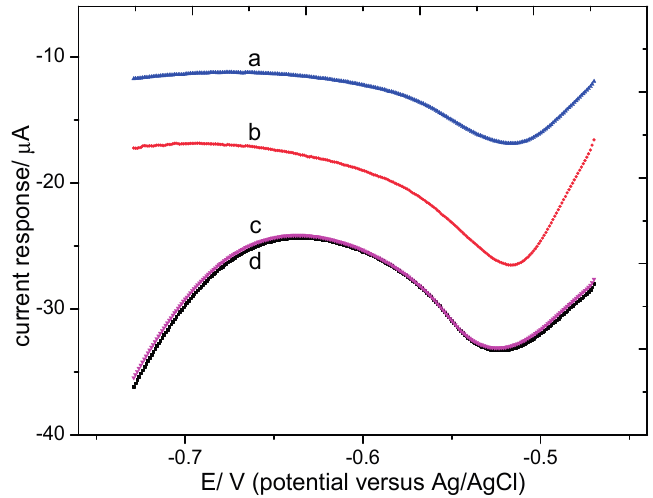
Figure 4. LSVs on ( a ) a tin modified electrode after several times of analysis, ( b ) a freshly